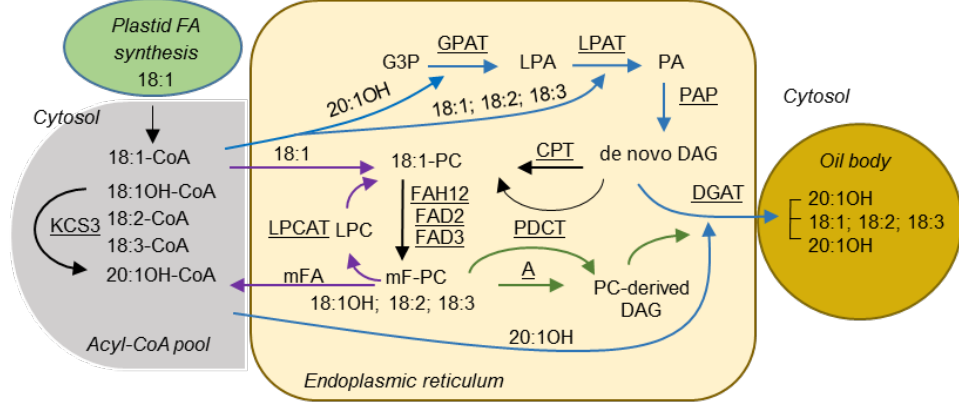
Figure 1. Proposed pathways for TAG biosynthesis in lesquerella seed. Blue arrows indicate reactions involved in Kennedy pathway. Purple arrows indicate reactions involved in acyl editing. Green arrows indicate reactions involved in PC-derived DAG synthesis. The rest of reactions are indicated by black arrows. Enzymes catalyzing these reactions are underlined. Fatty acid numerical symbols are described as in Table 2. Abbreviations: A, DAG production by the reverse reaction of CPT, phospholipase C or phospholipase D plus PAP; G3P, glycerol-3-phosphate; LPA, lysophosphatidic acid; PA, phosphatidic acid; LPC, lysophosphatidylcholine; PC, phosphatidylcholine; DAG, diacylglycerol; TAG, triacylglycerol; GPAT, glycerol 3-phosphate acyltransferase; LPAT, lysophosphatidic acid acyltransferase; PAP, phosphatidic acid phosphatase; FAH12, Δ12 oleic acid hydroxylase; FAD2, Δ12